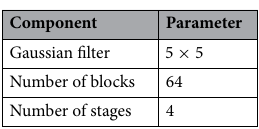
Table 5. Parameter setup of our proposed